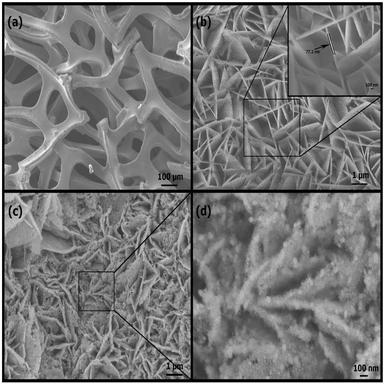
Shows SEM images of (a) bare Ni foam, (b) Ni(OH)2-NSAs@Ni foam, (c and d) Ni-NSAs@Ni foam at low- and high-magnification, respectively.